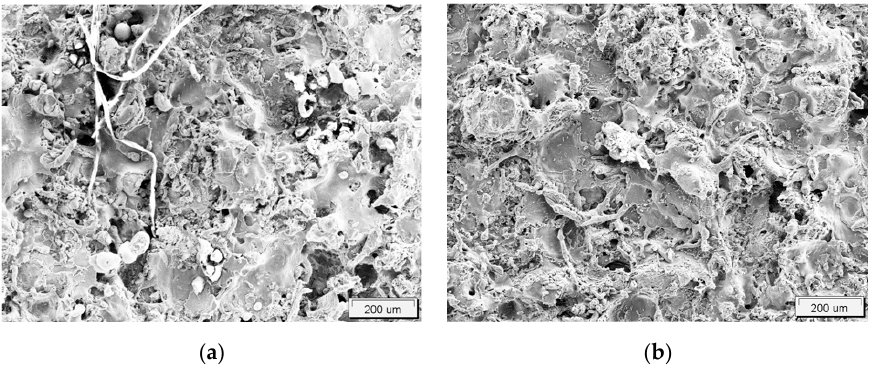
Figure 5. Images of the surface structure of wire 01T grade arc-sprayed aluminum: ( a ) without buffering subcoating; ( b ) buffered subcoating with 75B BondArc grade wire.